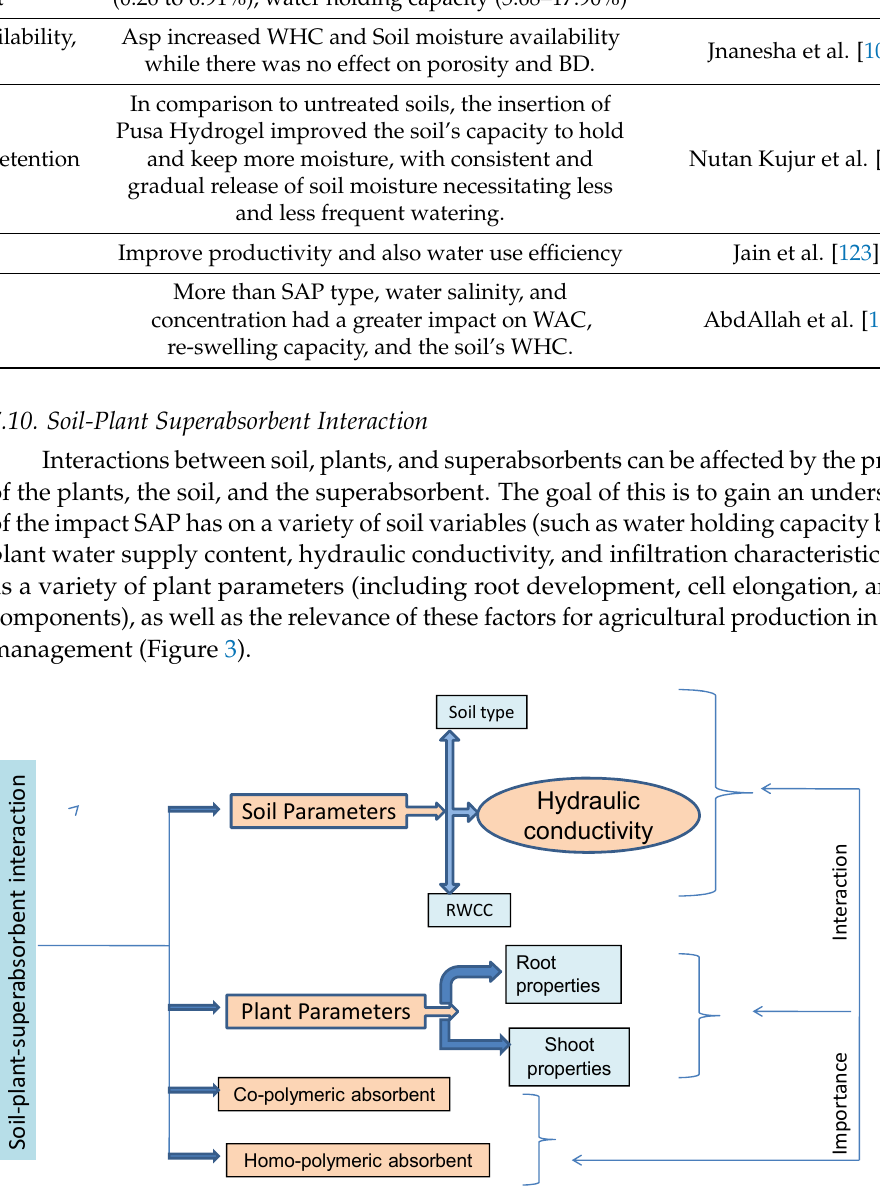
Figure 3. Important aspects of soil plant-super absorbent interaction are to be explored for drought